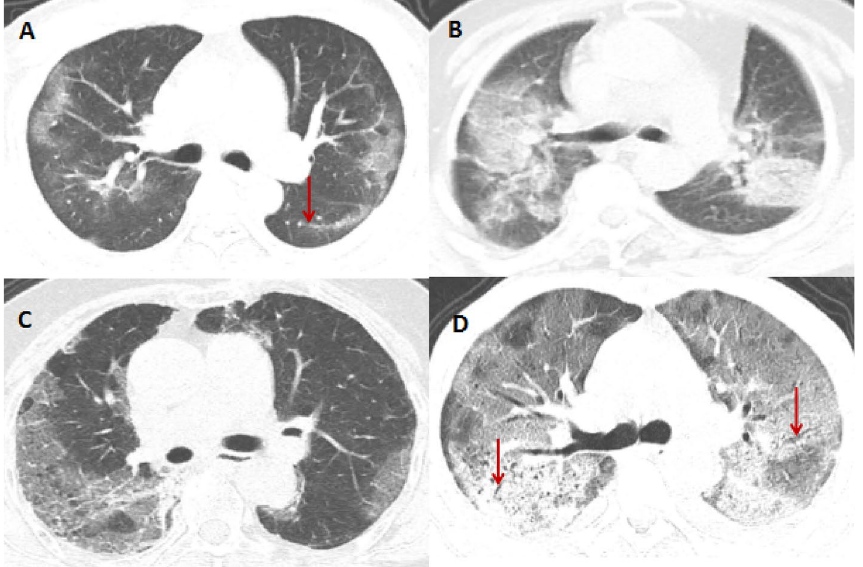
Figure 1. Main image manifestations and accompanying signs. ( A ) 34-year-old man; the main sign is bilateral subpleural ground glass opacities with left lower lung dorsal linear opacities (arrow); ( B ) 68-year-old man; the main signs are bilateral ground glass opacities and large consolidation; ( C ) 74-year-old woman; the main signs are bilateral ground glass opacities and reticular patterns, “crazy-paving” pattern, thickened small vessel shadows can be seen in the right lung lesions; ( D ) 59-year-old man; extensive lung glass shadow and partial consolidation shadow; lungs are white; air bronchial signs (arrows) can be seen in the background of bilateral exudation, and the dorsal pleura is slightly thicker. Imaging were acquired on GE AW VolumeShare software (Version number: 4.6; http:// www. gehea lthca re. com/ produ cts/ advan ced- visua lizat ion/ platf orms/ aw-